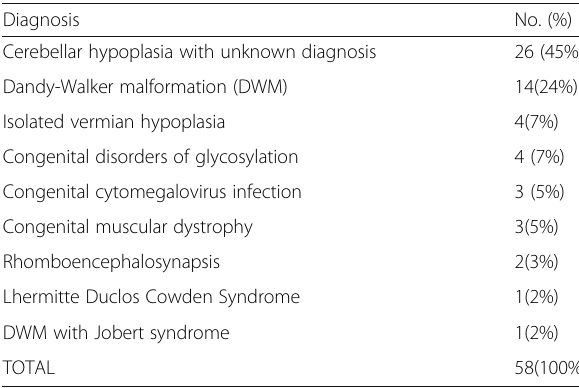
Table 2 Diagnostic classification of the patients included in the